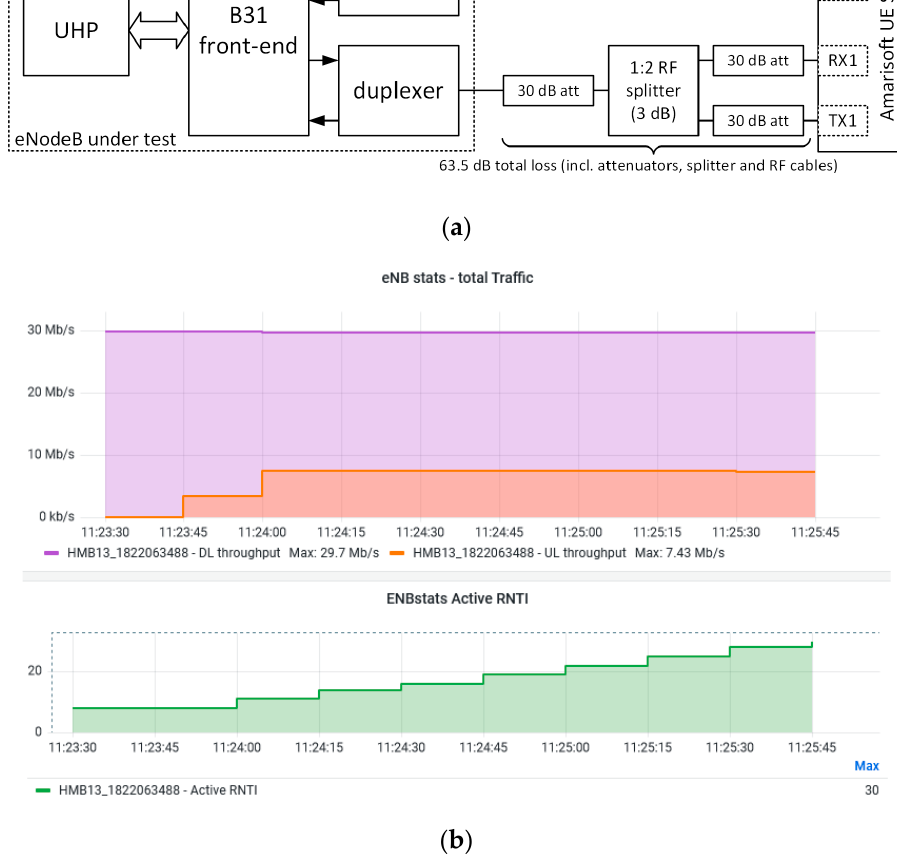
Figure 11. Validation of eNodeB performance under heavy traffic conditions: ( a ) test fixture block diagram and ( b ) total throughput obtained at the different number of active users in the cell (RNTI parameter), simulated with Amarisoft UE Simbox.